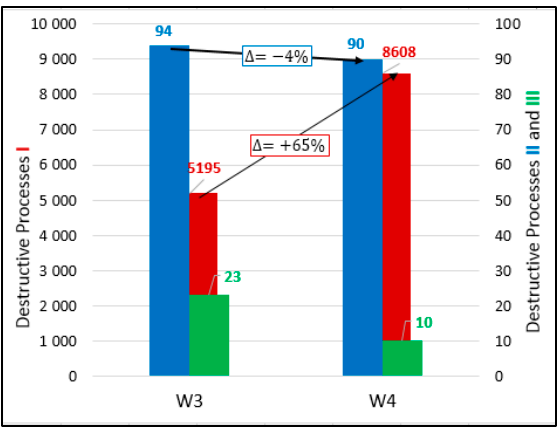
Figure 14. Number of hits accompanying processes I–III recorded in W3 and W4 samples (10 days curing, varied temperature, and with and without reinforcement).